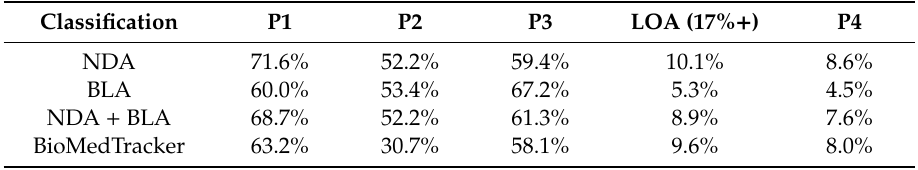
Table 10. POS / LOA in each phase of new drug development for the whole period